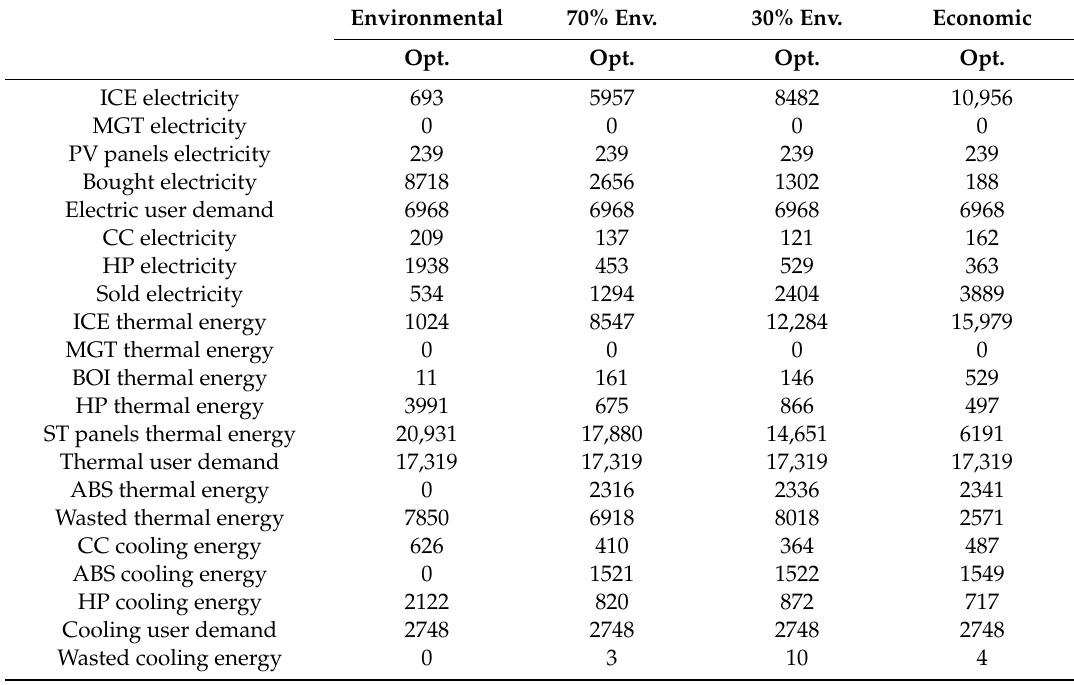
Table 14. Total optimal annual energy magnitudes (MWh)—distributed generation solutions integrated with the central solar